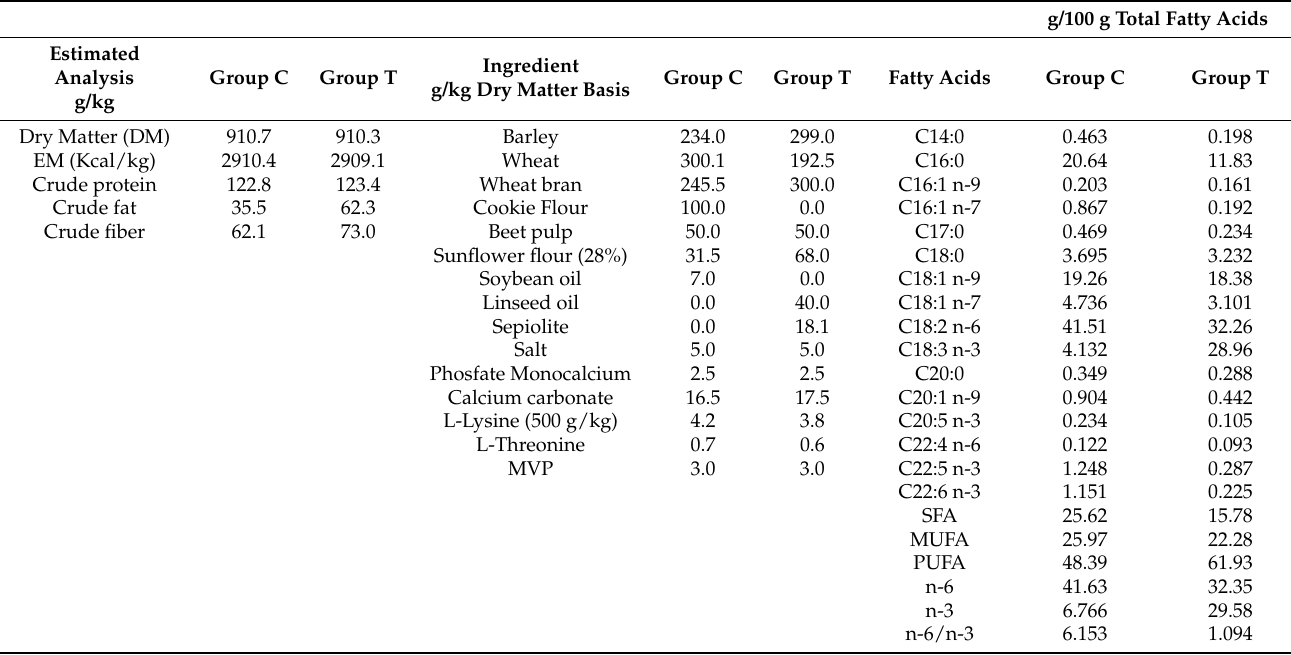
g/100 g Total Fatty Acids